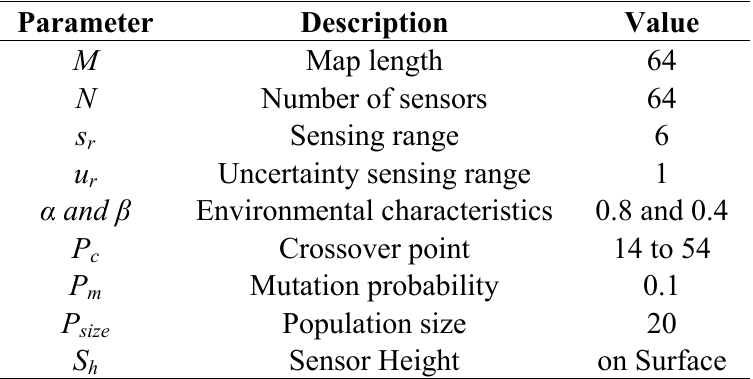
Table 1. Summary of